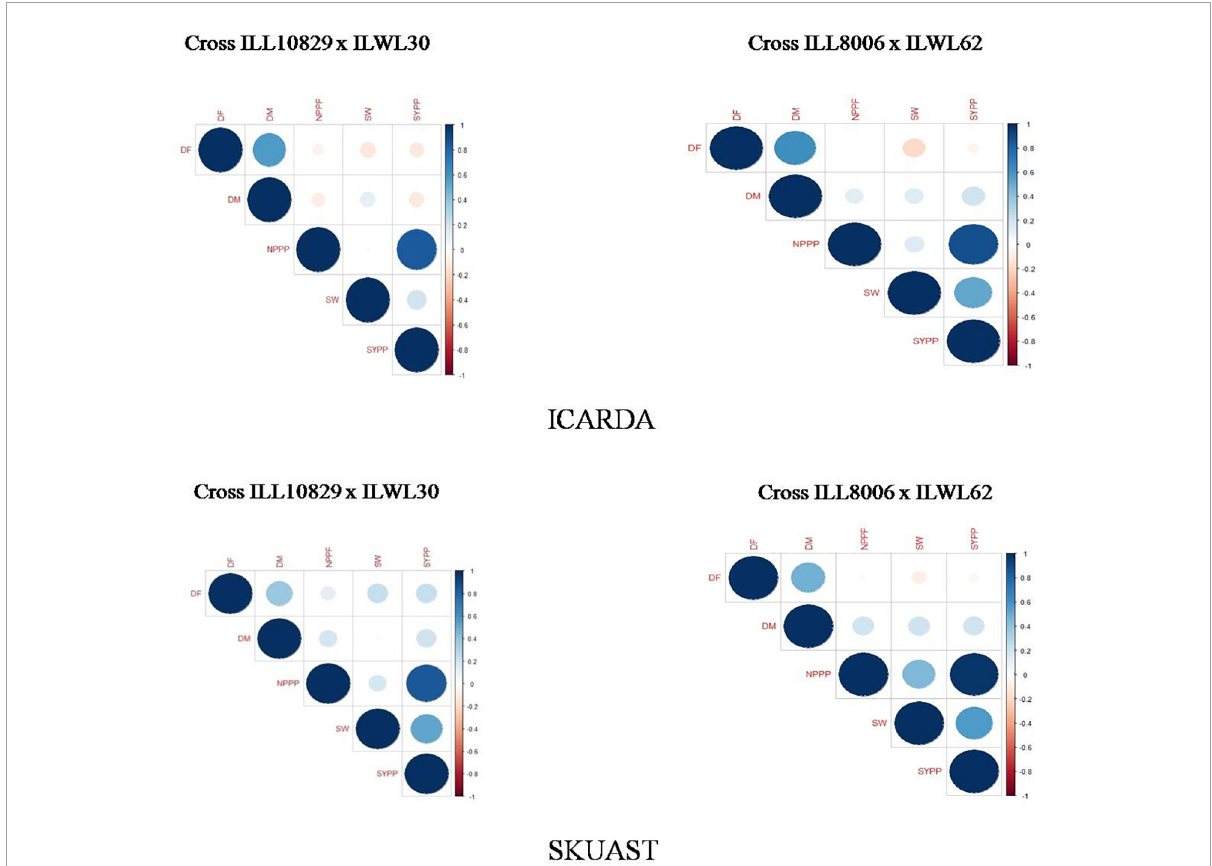
FIGURE4 Estimation of correlation plots for agro-morphological traits among lentil interspecific derivatives at ICARDA and SKUAST, India. DF, days to 50% flowering; DM, days to 80% maturity; NPPP, number of pods plant - 1 ; SW, 100-seed weight; SYPP, seed yield plant - 1 .